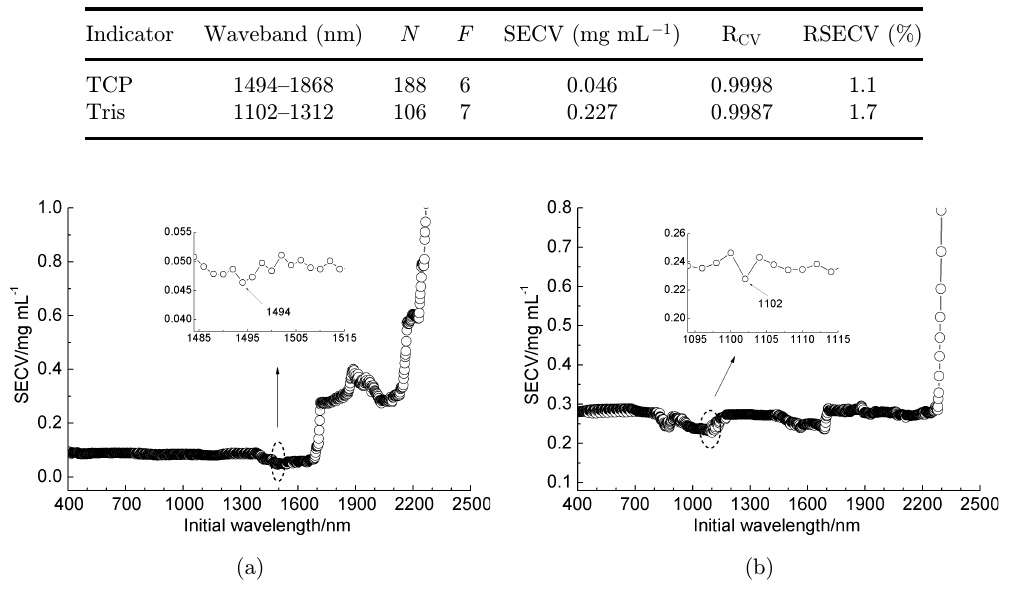
Fig. 8. Optimal SECV corresponding to the initial wavelength for (a) TCP and (b) Tris.